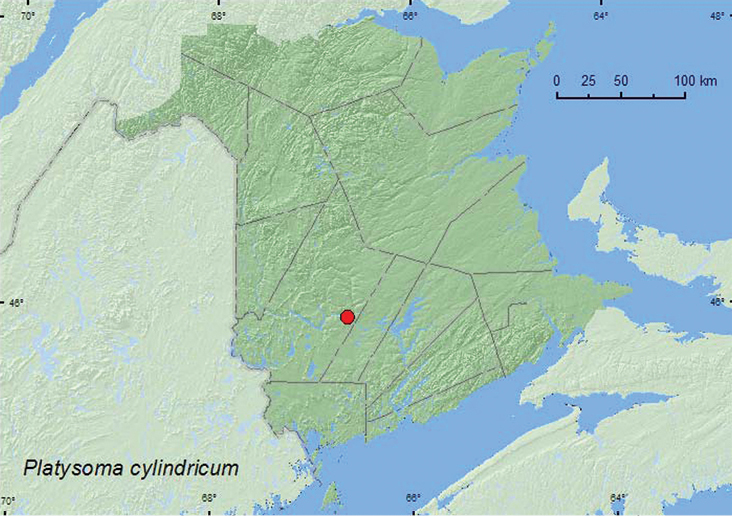
Collection localities in New Brunswick, Canada of Platysoma cylindricum.